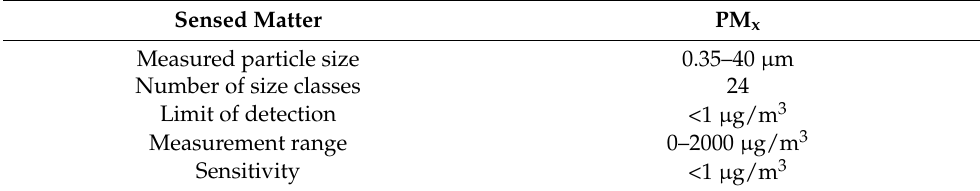
Table 1. Technical specifications of the Alphasense OPC-N3 sensor.